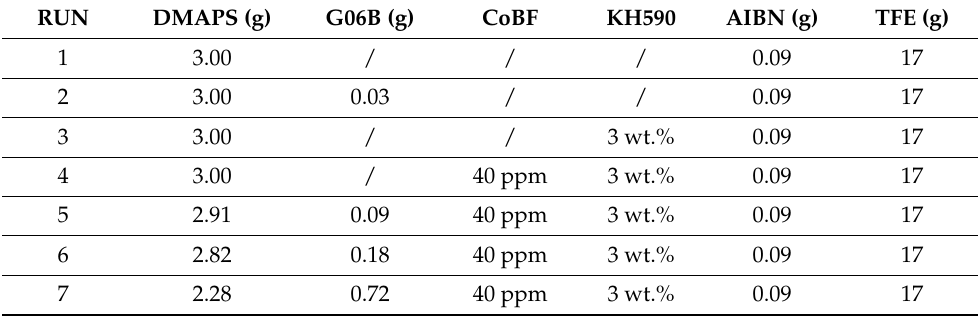
Table 1. The formulation of the betaine-type copolymer for